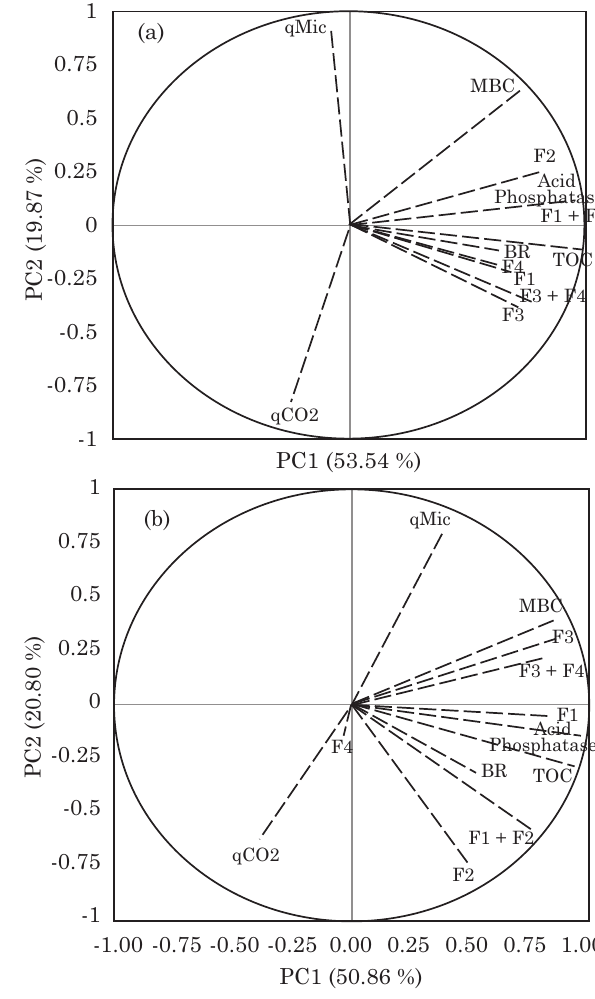
Figure 1. Ordination diagram derived from principal component analysis of the scores of treatments under split P applications and irrigation regimes: (a) 0-5 cm, (b) 5-10 cm.